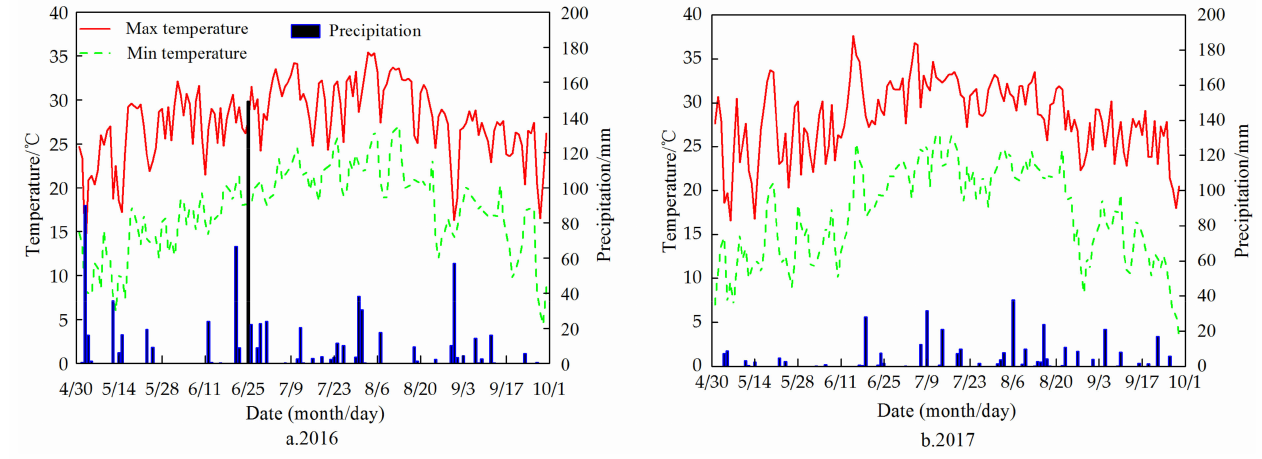
Figure 7. Daily temperature and precipitation during the maize growing season in 2016 and